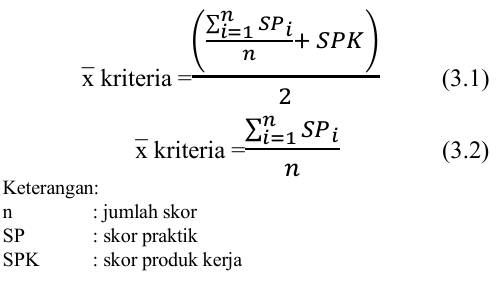
Pembangunan Tools Audit Sistem InformasiBerdasarkan COBIT 5 Pada Domain Align, Plan, and Organize